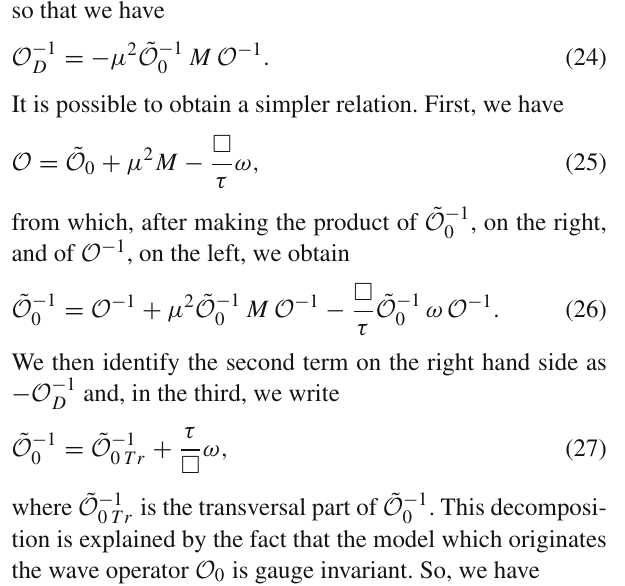
Fig. 1 Electron-electron scattering for the original massive